Question: Describe this figure in one sentence.
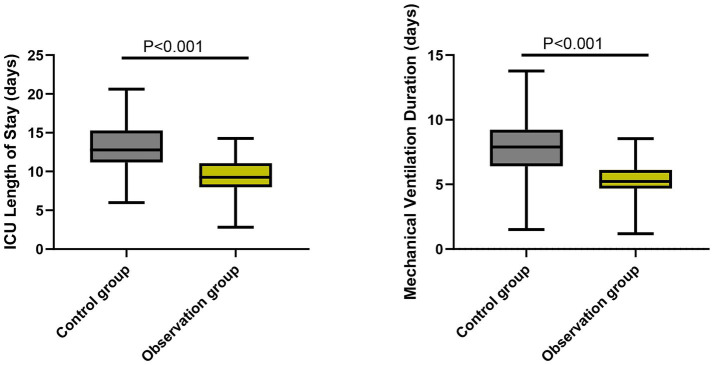
Answer: ICU length of stay and mechanical ventilation duration in the two groups. Box plots display the median, interquartile range, and range of the observed values. ICU length of stay was compared using an independent-samples t -test, and mechanical ventilation duration was compared using Welch’s t -test.